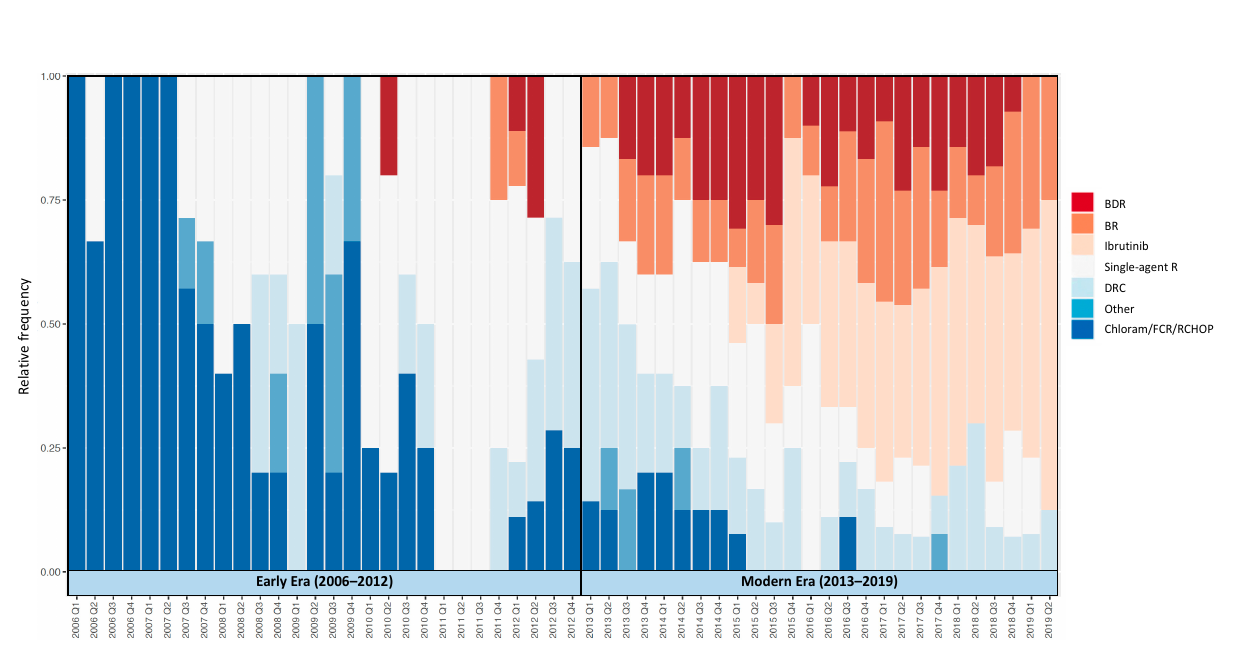
Figure 2. 1 L treatment patterns in veterans with Waldenström macroglobulinemia, 2006–2019: ( a ) 1 L treatment pattern in younger patients ( ≤ 70 years of age at initiation of 1 L therapy); ( b ) 1 L treatment pattern in older patients (>70 years of age at initiation of 1 L therapy).1 L: first-line treatment; BDR: bortezomib and dexamethasone +/ − rituximab; BR: bendamustine +/ − rituximab; Chloram: chlorambucil; DRC: dexamethasone, rituximab, and cyclophosphamide; FCR: fludarabine and cyclophosphamide +/ − rituximab; R: rituximab; RCHOP: cyclophosphamide, doxorubicin, vincristine, and prednisone ± rituximab.